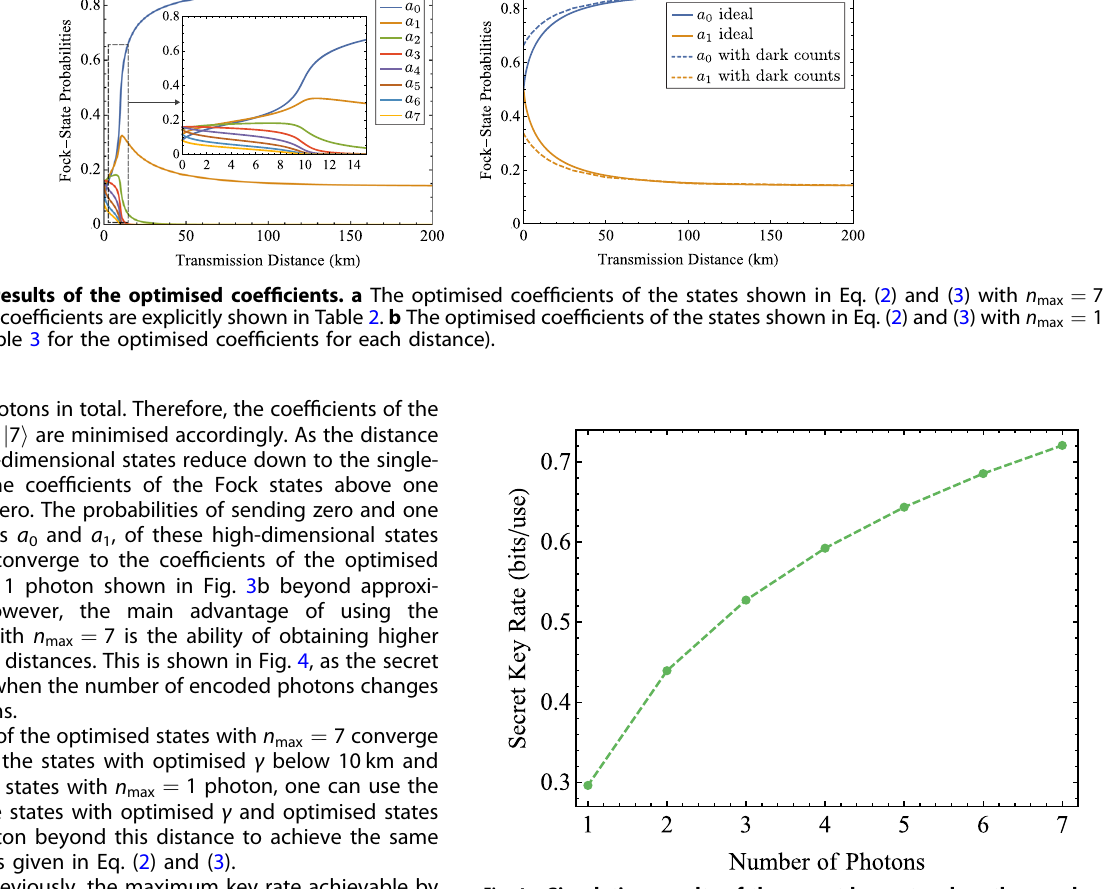
Fig. 4 Simulation results of the secret key rate when the number of encoded photons varies from 1 to 7 photons at 5 km. The states are in the form of Eq. (2) and (3) where the coef fi cients of each state are optimised.